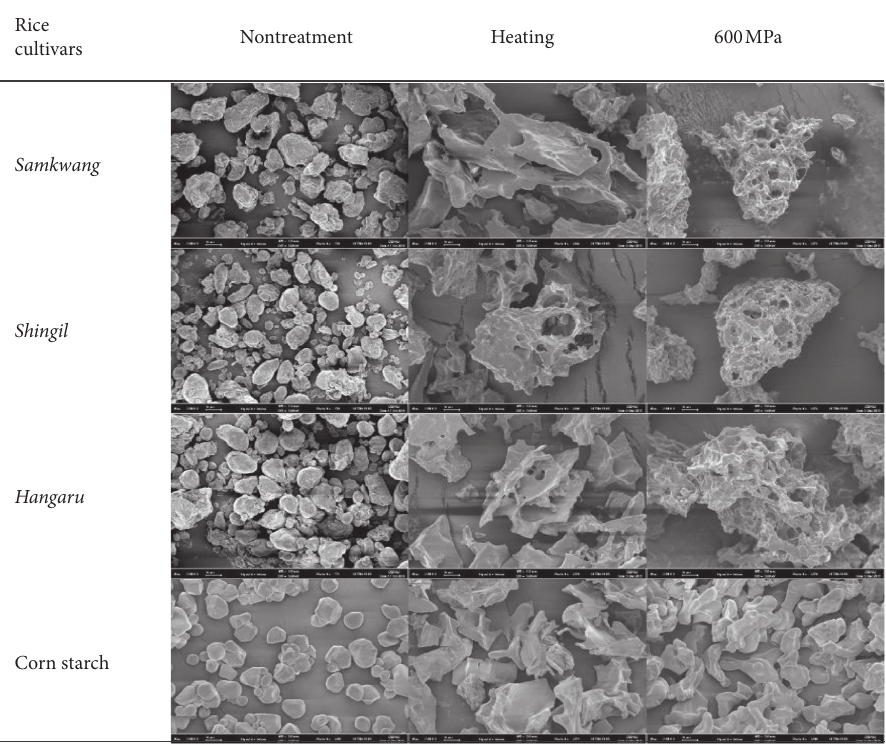
Figure 1: Scanning electron microscope of different rice flours by treatment methods ( × 200).